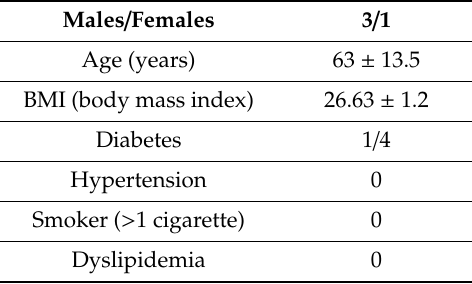
Table 1. Demographic data of